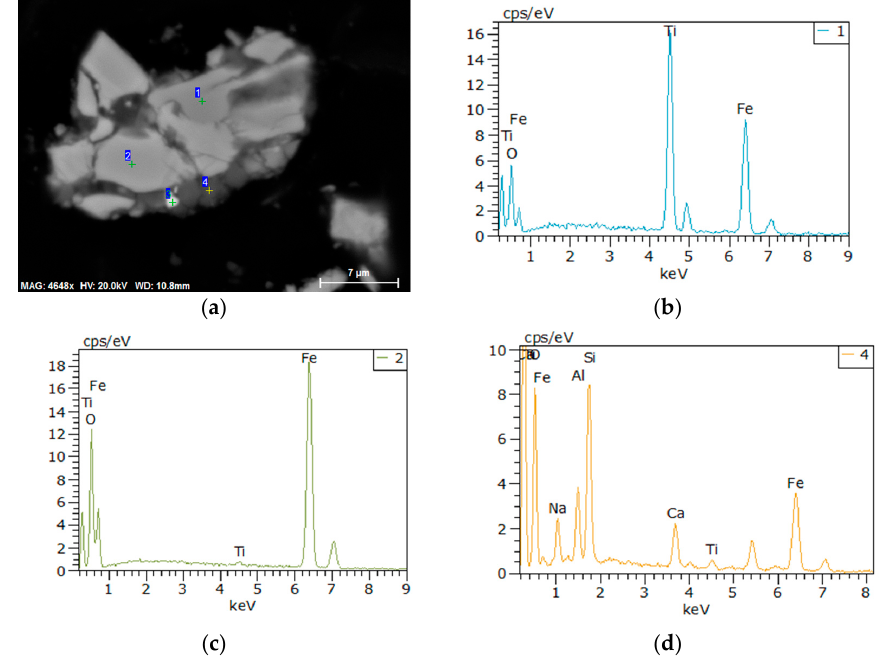
Figure 2. SEM image of LGVTM and corresponding EDS analyses of areas 1, 2, and 4: ( a ) SEM image of LGVTM; ( b ) EDS analysis of area 1; ( c ) EDS analysis of area 2; ( d ) EDS analysis of area 4.